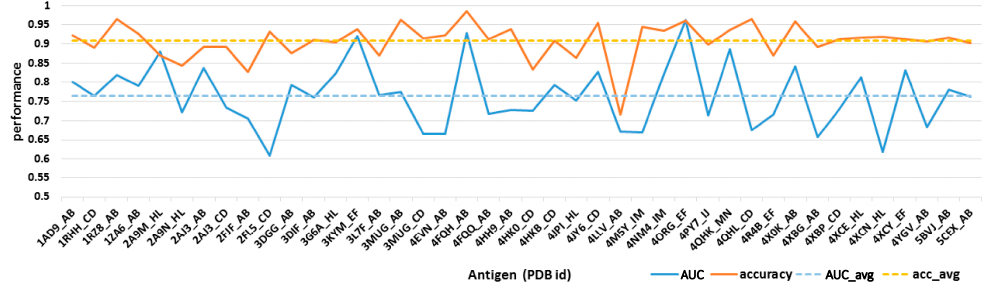
Figure 3. Model evaluation through ten-fold cross-validation. Solid lines refer to the area under roc curve (AUC) value and prediction accuracy for each immunogenic antibody while dashed lines refer to the averaged AUC and accuracy (acc).